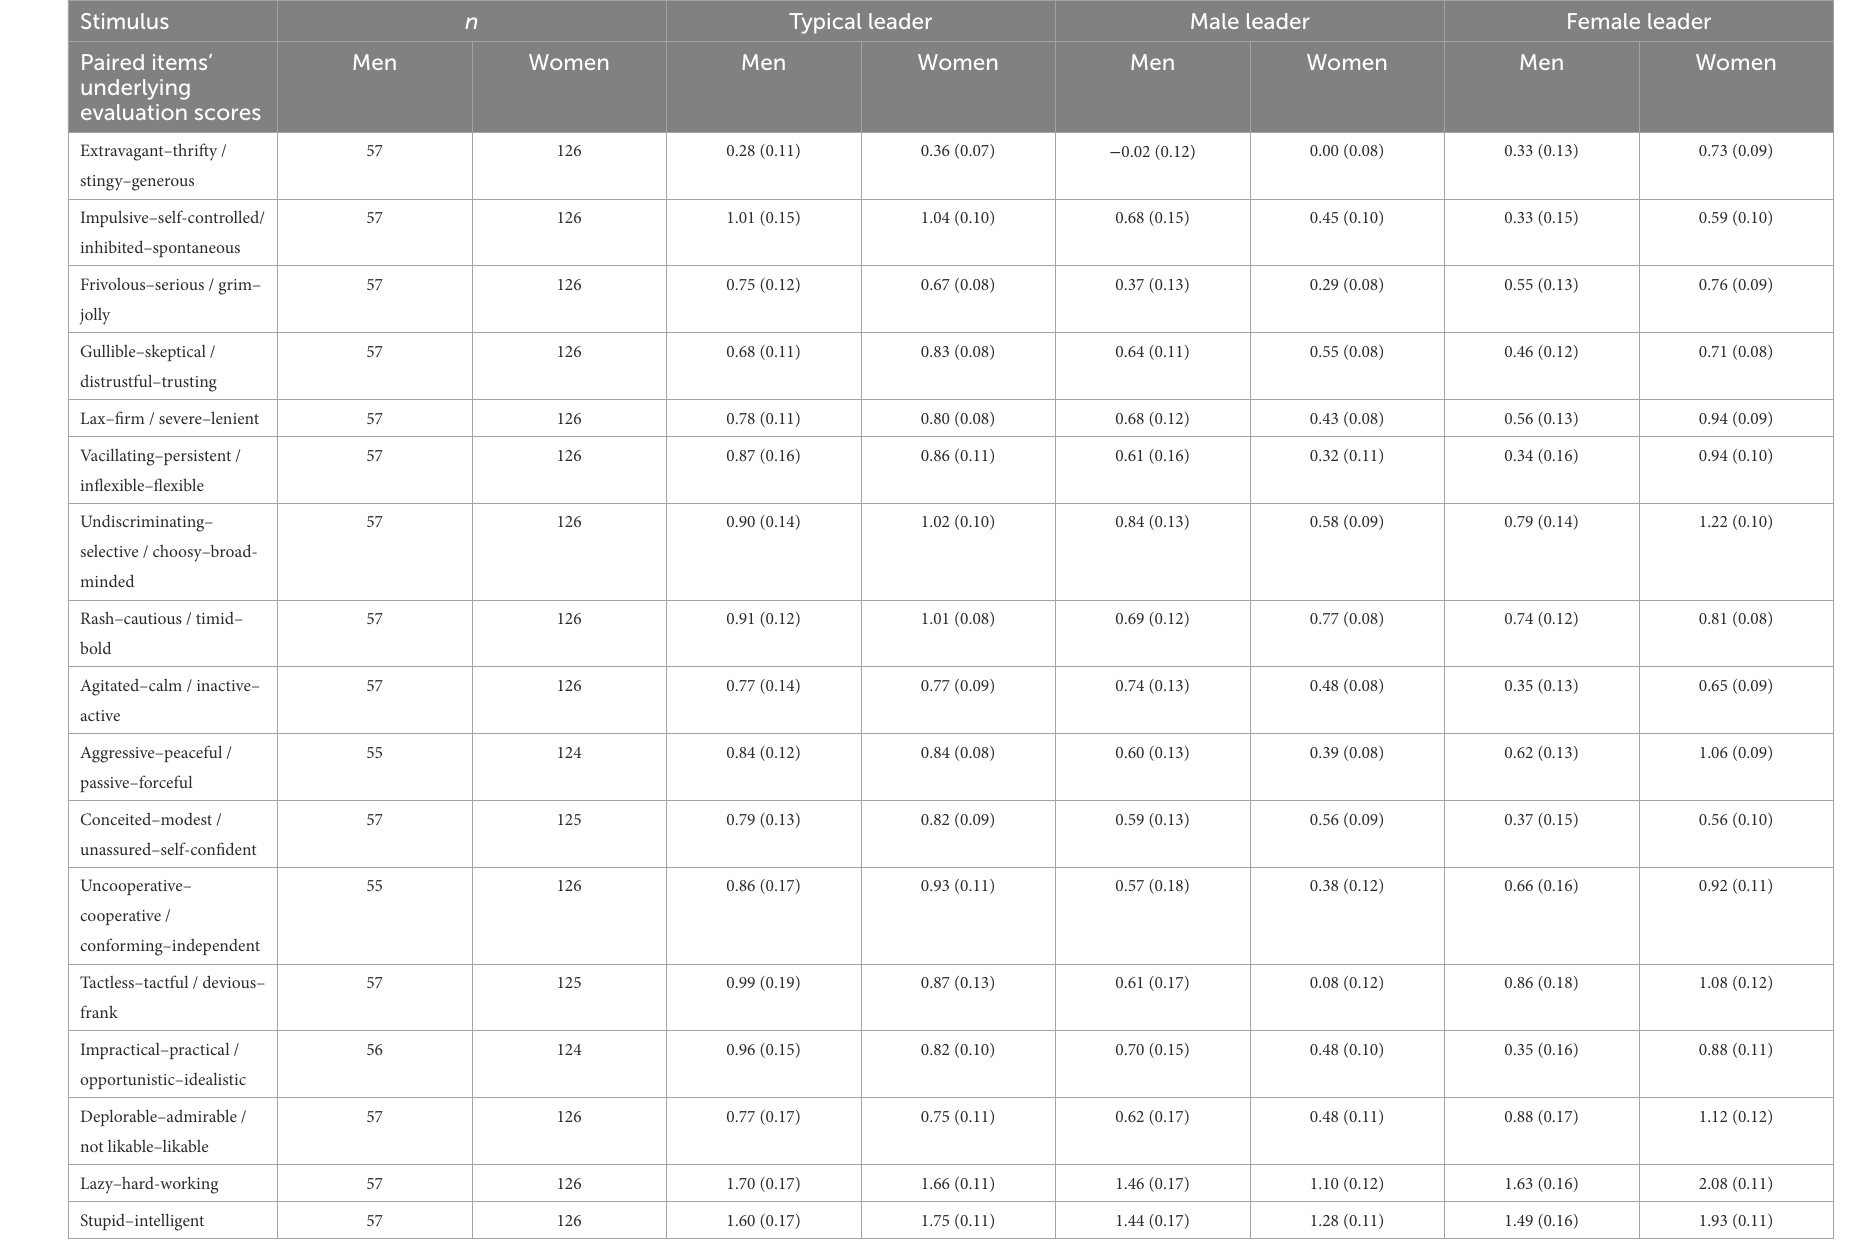
Adjectives on the left are negatively evaluated and adjectives on the right are positively evaluated; values outside parentheses are estimated marginal means ranging from − 3 (= negative evaluation, left adjective of the pair) to + 3 (= positive evaluation, right adjective of the pair); values in parentheses indicate standard